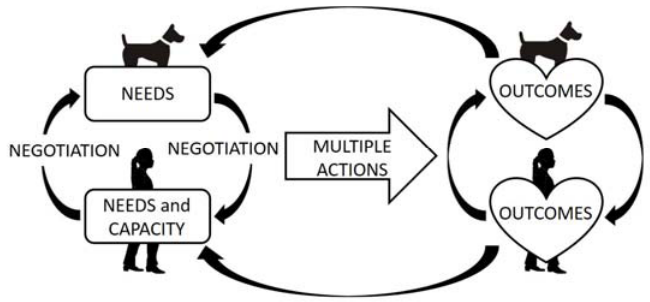
Figure 1. Model of dog walking negotiation. Schematic representation of interplay between the construction of dog and owner needs (which include internal and external influences; for example, enculturation), multiple possible actions taken by the owner, and perceived outcomes for dog and owner (internally and externally; for example, connectedness).